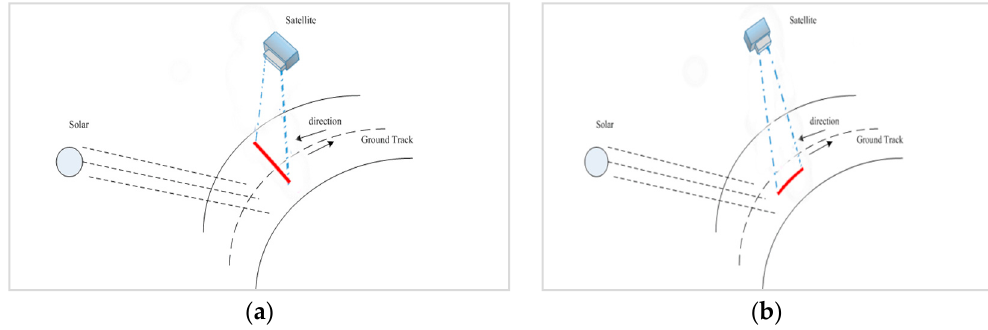
Figure 13. Schematics of ( a ) normal and ( b ) 90° yaw imaging methods in the SPARK satellite.